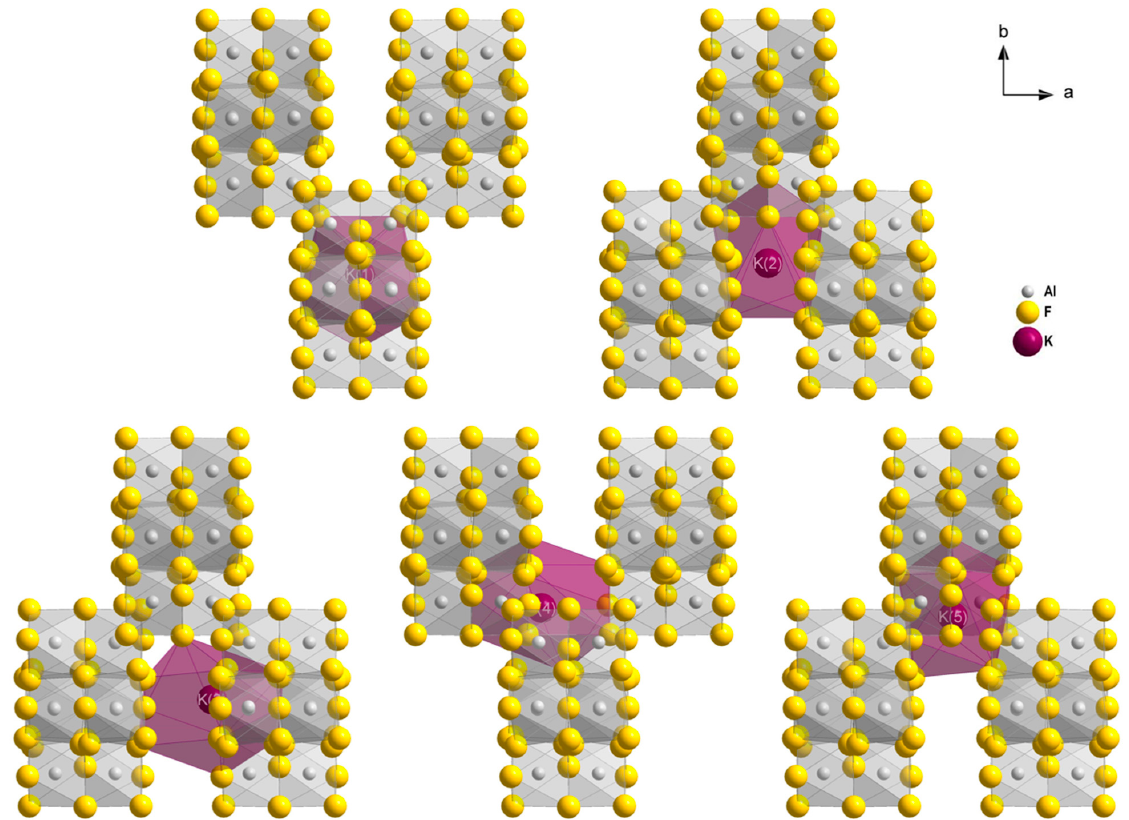
Figure 7. Interconnection of the infinite fluoridoaluminate zig-zag chains by potassium ions in K 2 AlF 5 -3. Table 5. Selected interatomic distances (in pm) in K 2 AlF 5 -3.